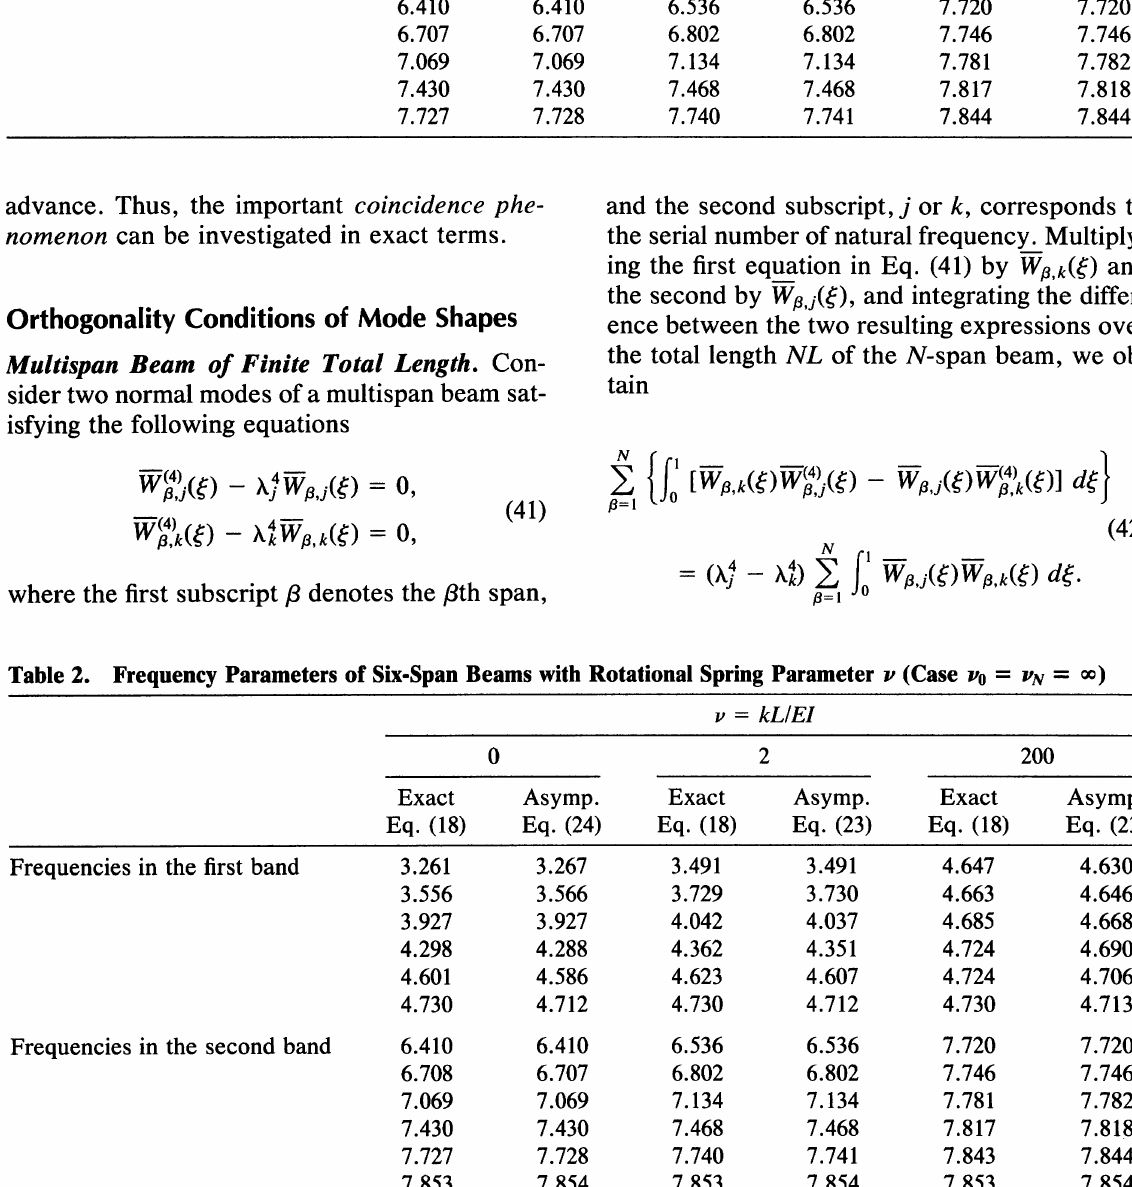
v = kLlEI 0 2 200 Exact Asymp. Exact Asymp. Exact Asymp. Eq. (18) Eq. (24) Eq. (18) Eq. (23) 3.261